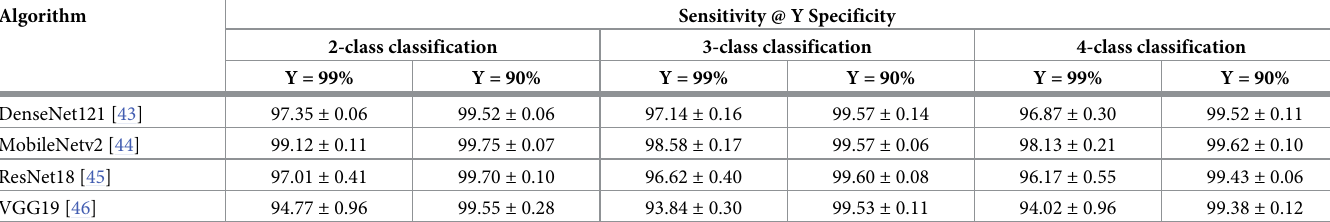
Table 4. Evaluation of existing deep learning algorithms for COVID-19 prediction corresponding to all classification protocols. In the case of multi-class classifica- tion, a one-vs-all strategy is used to report sensitivity for COVID detection. Algorithm